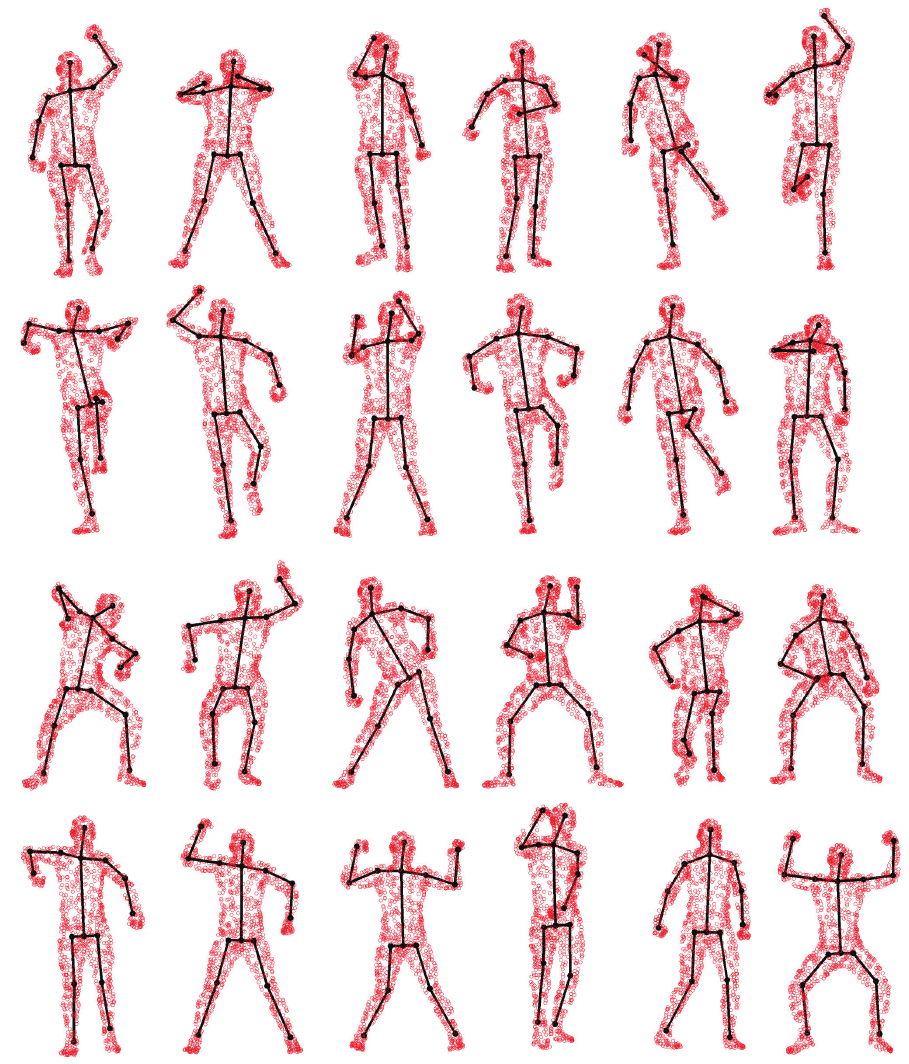
Figure 15. Pose estimation results for some SCAPE